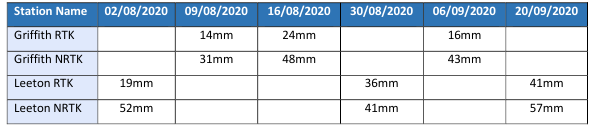
Table 4 : Maximum height difference for each day of observations